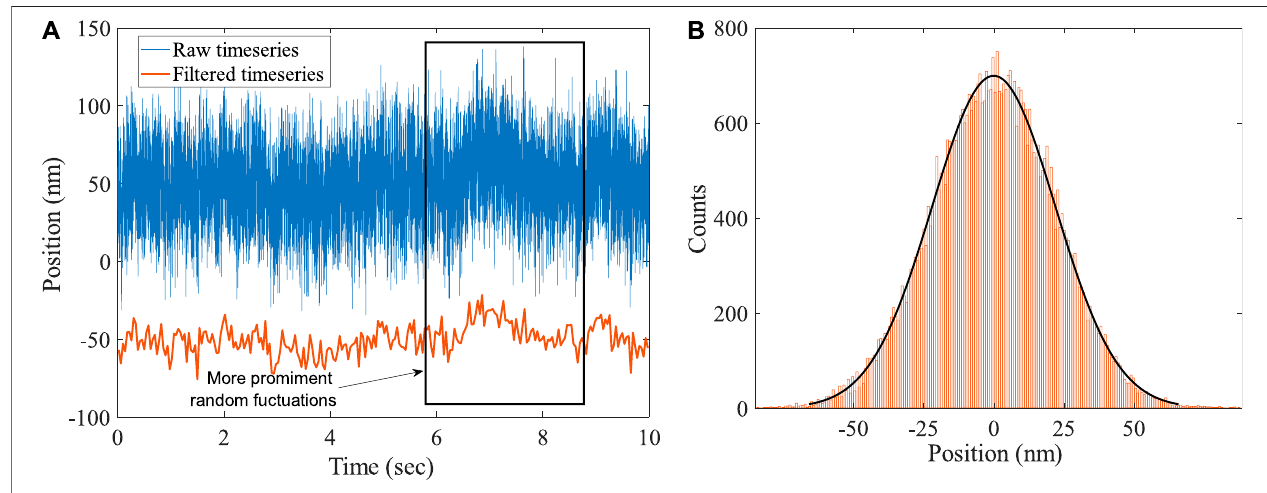
FIGURE 2 | (A) Typical time series data of the position fl uctuation of an optically trapped Brownian polystyrene bead of radius a (cid:1) 1 . 5 μ m. Discrete samples are taken from its trajectory along one coordinate at 5 kHz in this case. The box in the left shows the data where there is minimum fl uctuation and the box on the right delineates a part of the time series where there is a minor fl uctuation. (B) The histogram of the position fl uctuation.